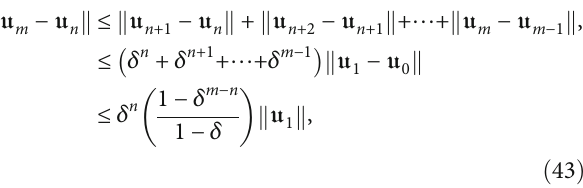
for μ = 0 : 60 . (d) NTDM ABC